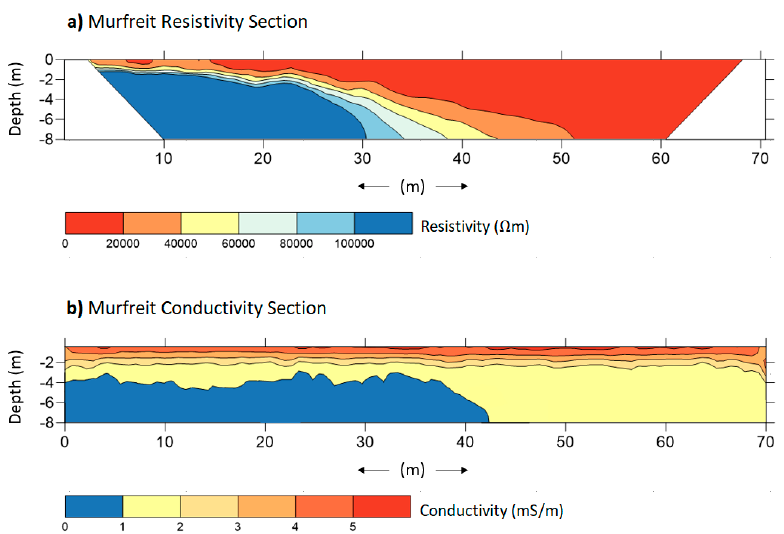
Figure 5. Inverted ( a ) resistivity and ( b ) conductivity sections obtained with ERT and FDEM surveys performed with an investigation line longitudinal to the development of the Murfreit rock glacier.